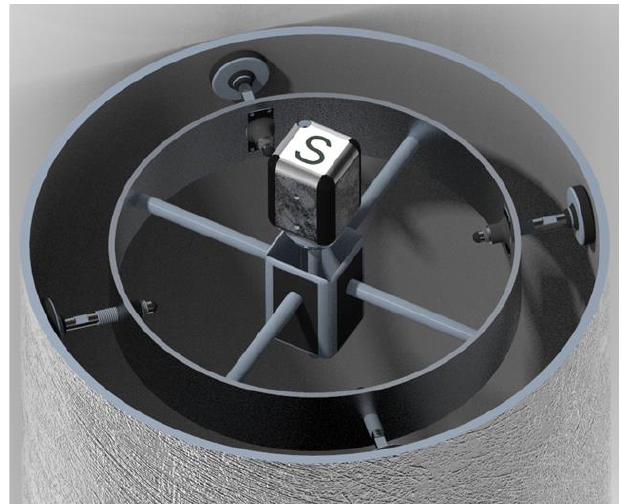
Figure 4. Design 2 - Circular